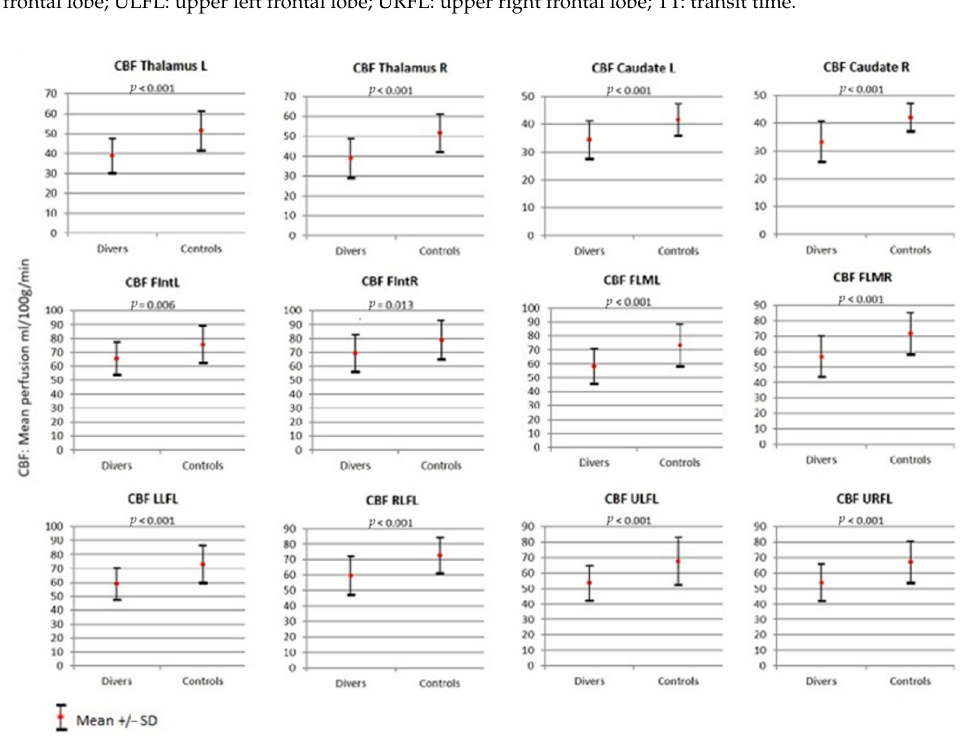
Abbreviations: CBF: cerebral blood flow; L: left; R: right; FIntL: frontal internal left; FIntR: frontal internal right; FLML: frontal lobe, middle left; FLMR: frontal lobe, middle right; LLFL: left lower frontal lobe; RLFL: right lower frontal lobe; ULFL: upper left frontal lobe; URFL: upper right frontal lobe; TT: transit time.